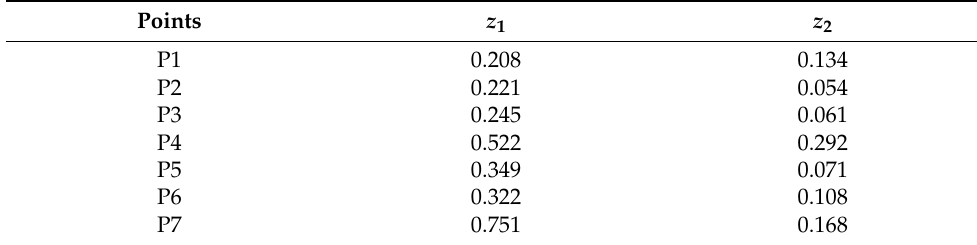
Table 4. Positioning errors (m) for P1–P7 in 90% of the cases after the LKF fusion. Points